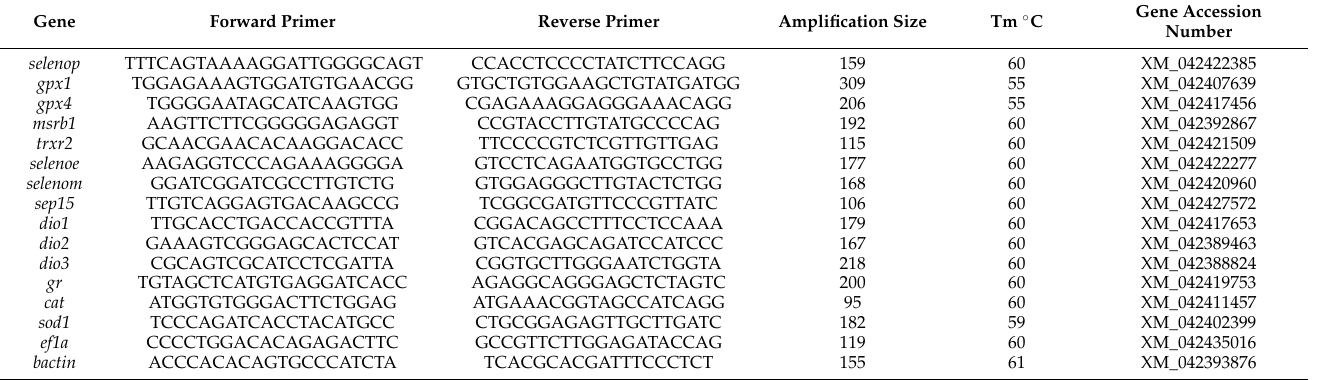
Table 2. Primer sequences used to assay mRNA levels by real-time